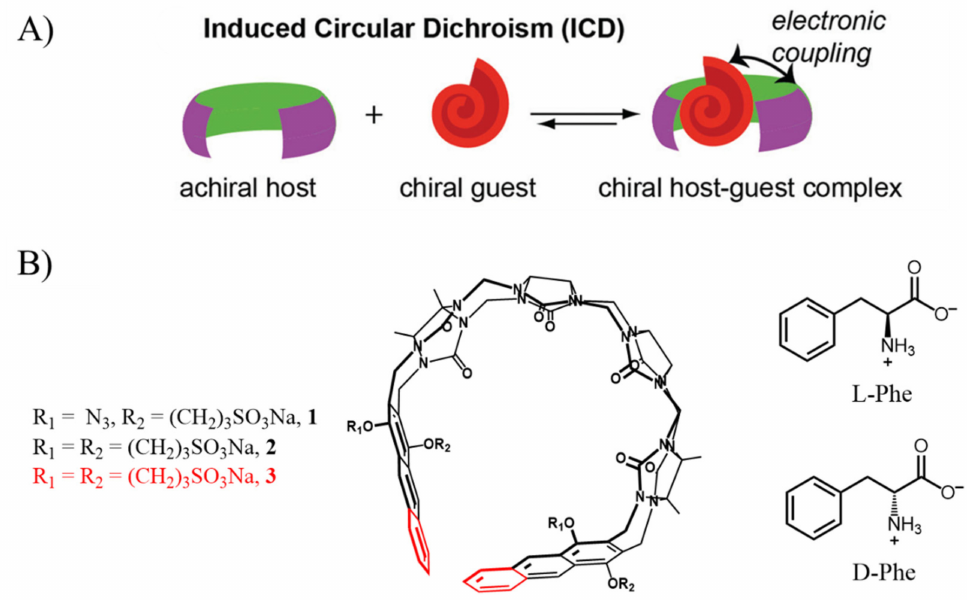
Figure 2. ( A ) The combination of subject and object of open-loop CB[n]s. Reprinted (adapted) with permission from Ref. [7] Copyright 2020 from The Royal Society of Chemistry. ( B ) Chemical structure of acyclic CB[n]s ( 1 , 2, and 3 ) and the chiral guests